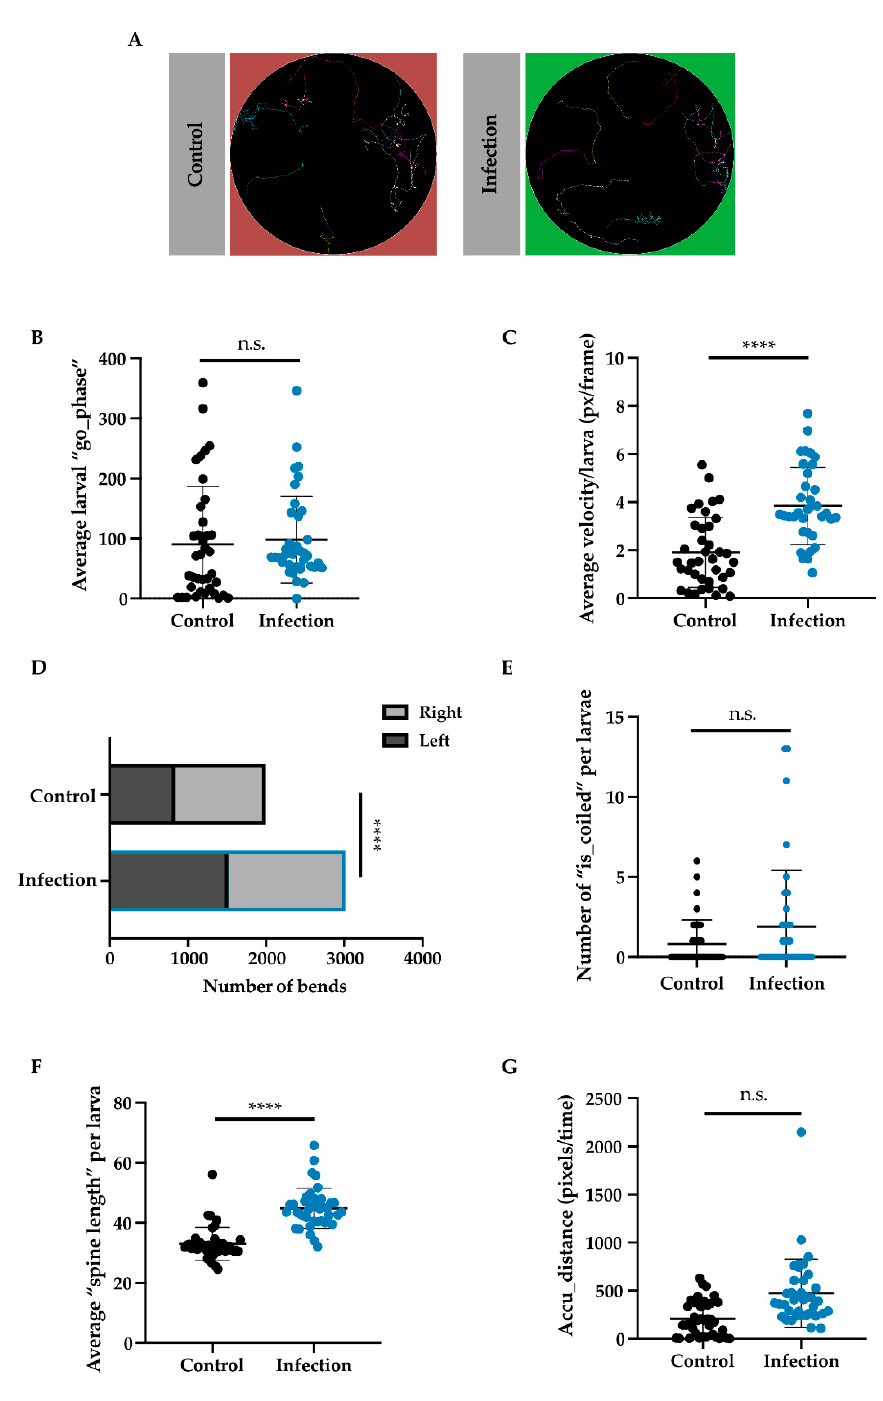
Figure 5. Tracking larval behavior after infection with Heterorhabditis . Over 480 s, larval behavior was tracked using Frustrated Total Internal Reflection-Based Imaging Method (FIM) software. Representative images of larval tracks ( A ). One still was taken per second, and the larval movement was detected using parameters, such as the go phase ( B ), velocity ( C ), bending preference ( D ), coiled ( E ) spine length ( F ), and accumulated distance ( G ). Each dot represents a larva’s average value in that parameter throughout the imagining. Forty larvae were analyzed, and data are shown as mean ± SD; n.s. = not significant, **** p < 0.0001.